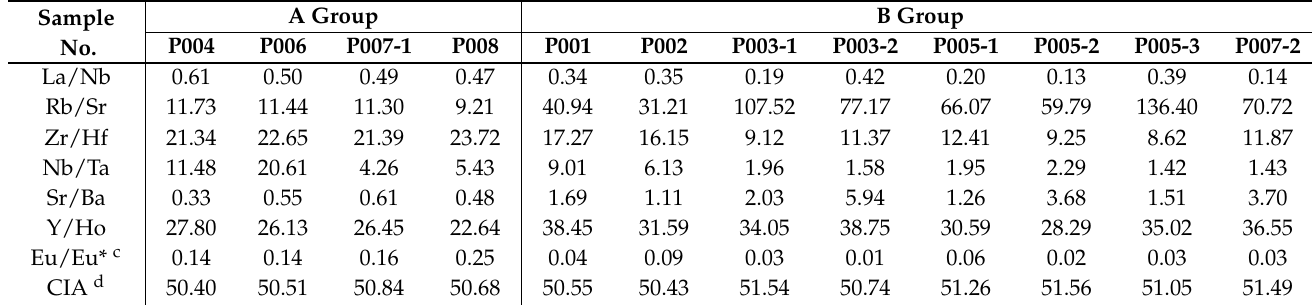
Table 3. Whole-rock concentrations and Rb-Sr and Sm-Nd isotopic parameters of Pirrit Hills granite samples. Sample No.